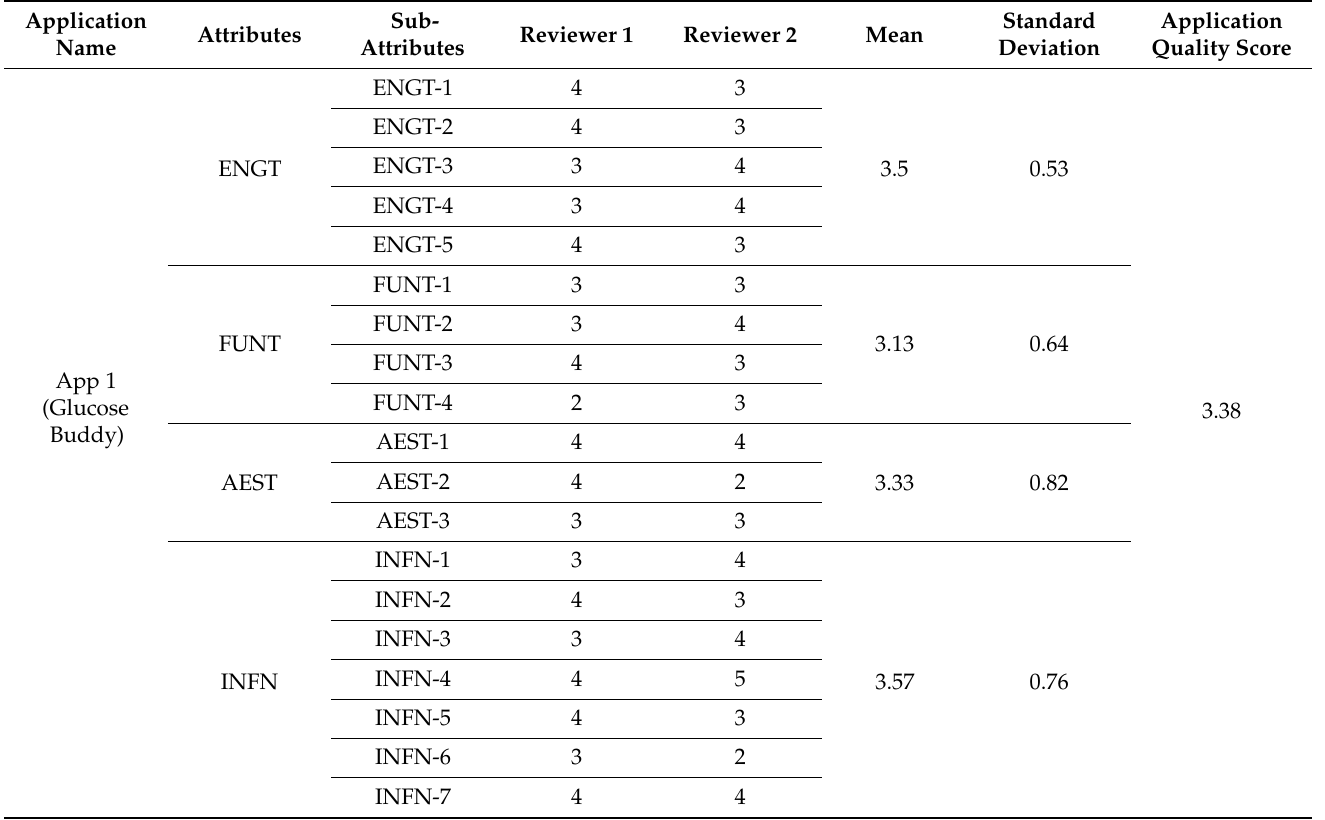
Table 2. Category I, including the Application Quality Mean